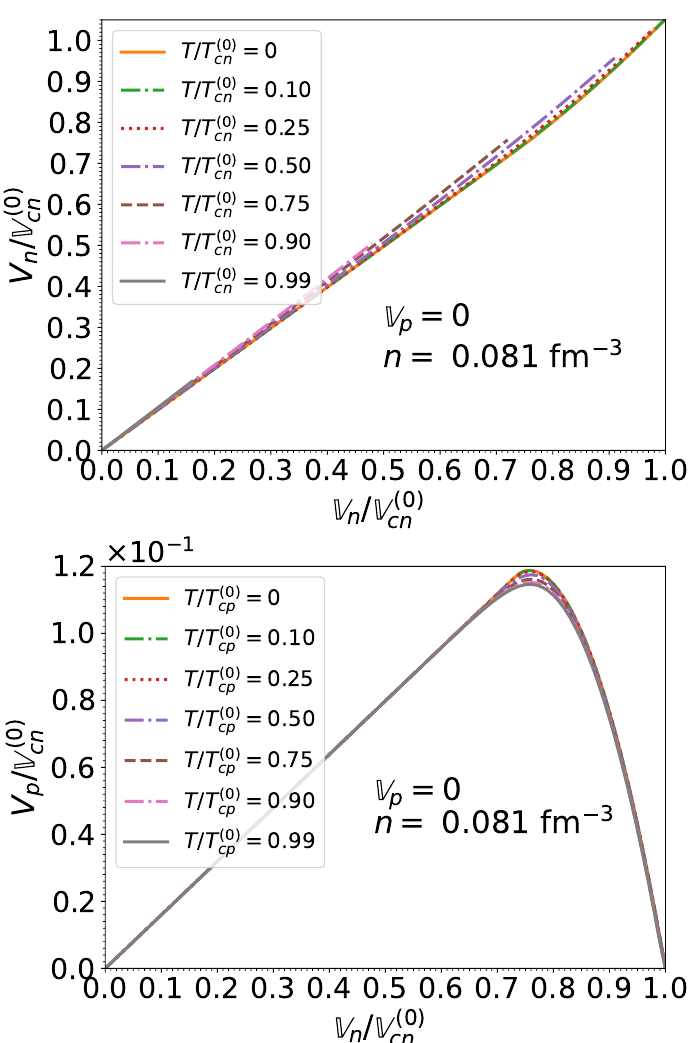
Figure 9. Upper panel: neutron superfluid velocity V n relative to the corresponding critical velocity as a function of the normalized effective neutron superfluid velocity V n / V beta-equilibrium at the crust-core interface for different temperatures. Results were obtained for V p = 0. Lower panel: same for the proton superfluid velocity V p